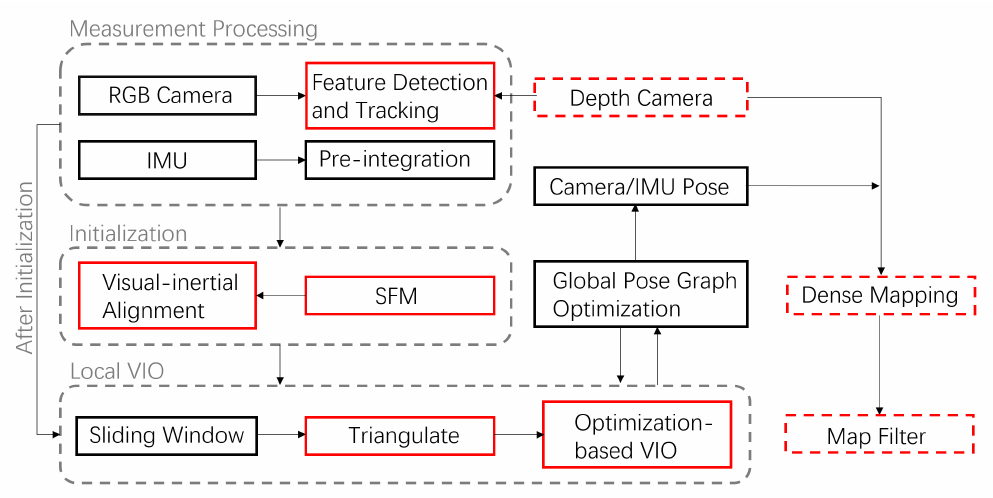
Figure 1. Core system structure. The solid line blocks indicate the original core pipeline of VINS-Mono. Red solid line blocks represent the modules of VINS-Mono that we modified. Red dashed line blocks represent the modules we newly added. VINS-Mono starts with the input of a color image sequence and IMU flow. IMU values are pre-integrated between every color frame, while visual features are detected and tracked. Then, the data is passed to SFM (Structure From Motion) to get an up-to-scale pose estimation. Once the visual and inertial alignment and initialization are done, the system starts to do a sliding window based local VIO process and is using the global pose graph optimization module to achieve the loop-closure task. The camera pose is then in a global consistent